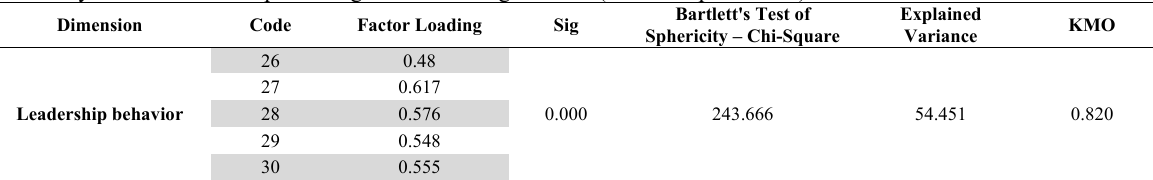
EFA analysis for the items representing the moderating variable (Leadership behavior)